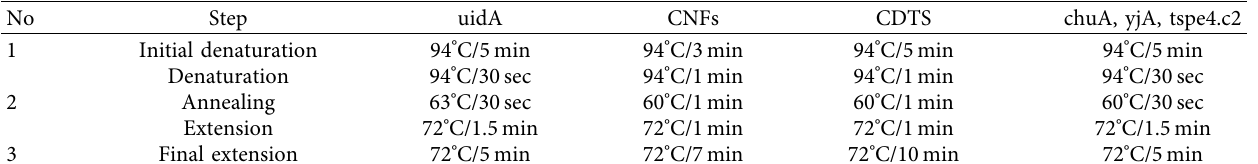
Table 2: Termal cycles for eleven primers are used in this study.